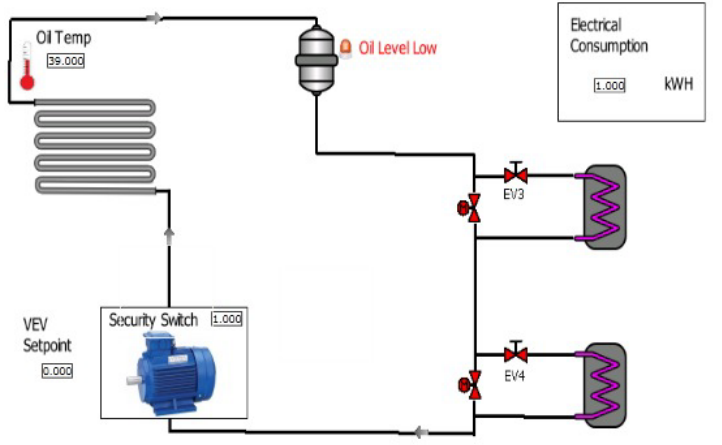
Figure 2. HMI for the SCADA process.